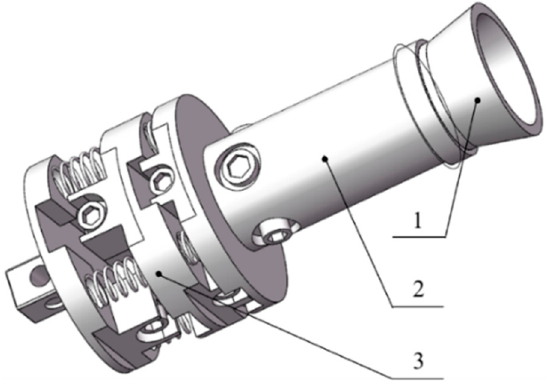
Figure 11. The end-effector of the cutter-changing robot. 1—The guiding mechanism, 2—The uni- versal wrench, 3—The flexible connecting mechanism. universal wrench, 3—The flexible connecting mechanism.